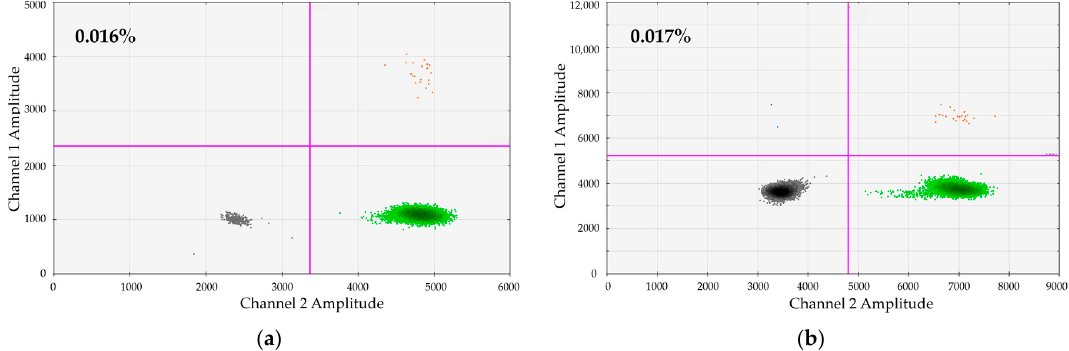
Figure 3. High sensitivity of dPCR-based chimerism detection. In the shown example, an artificial dilution of 0.01% MNCs positive for the marker DP114-I/DP131-I was generated in DP114-I-/DP131-I-negative MNCs. Six hundred nanograms of gDNA were subjected to duplex-dPCR using assays: ( a ) DP114-I (FAM, channel 1) vs. SRY (HEX, channel 2); and ( b ) DP131-I (FAM, channel 1) vs. Ref (HEX, channel 2).